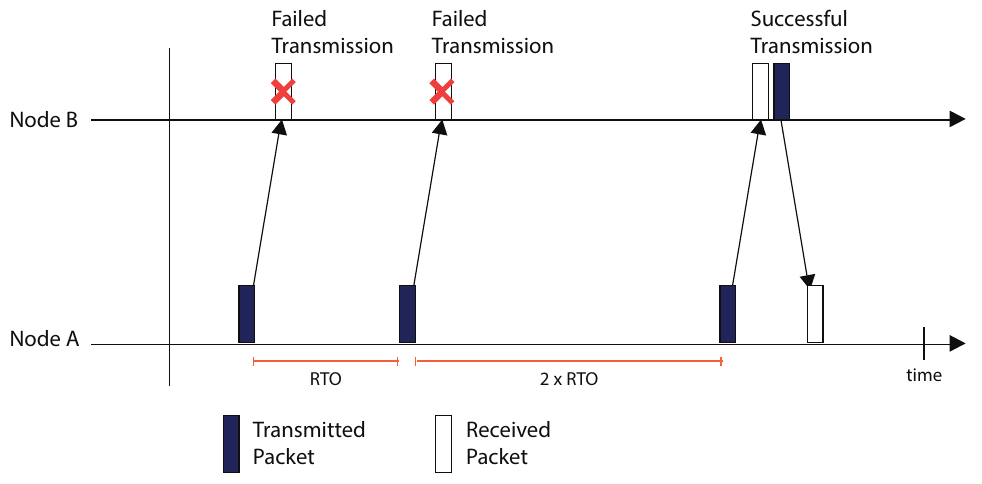
Figure 4. CoAP Default Congestion